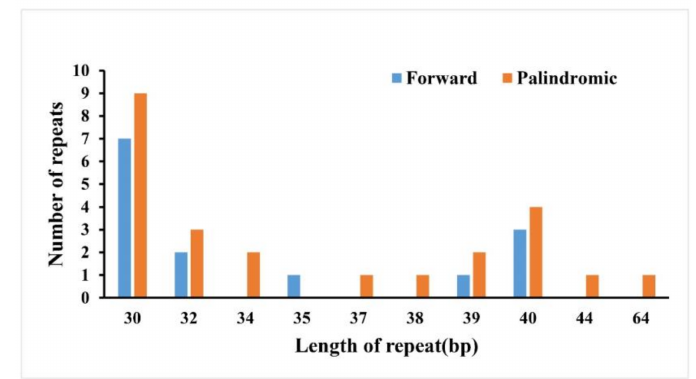
Figure 2. Analysis of repeated sequences in Q. aquifolioides .